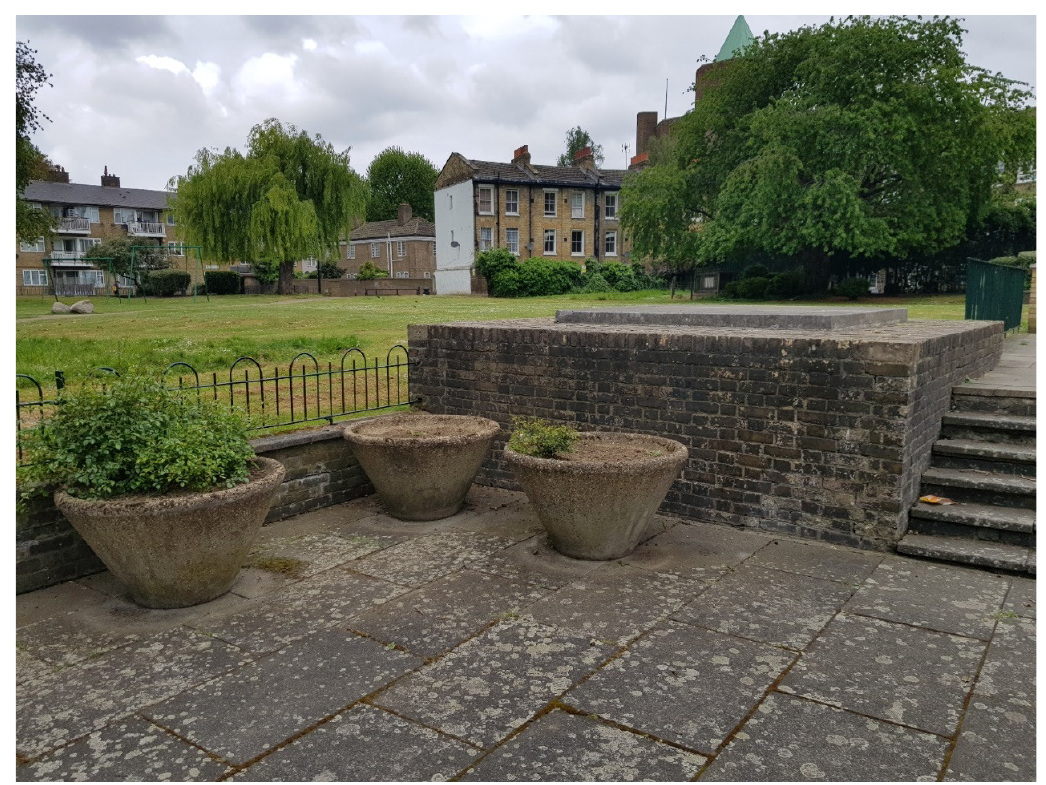
Figure 2. Empty plinth of Sydney Harpley’s The Dockers , Lansbury